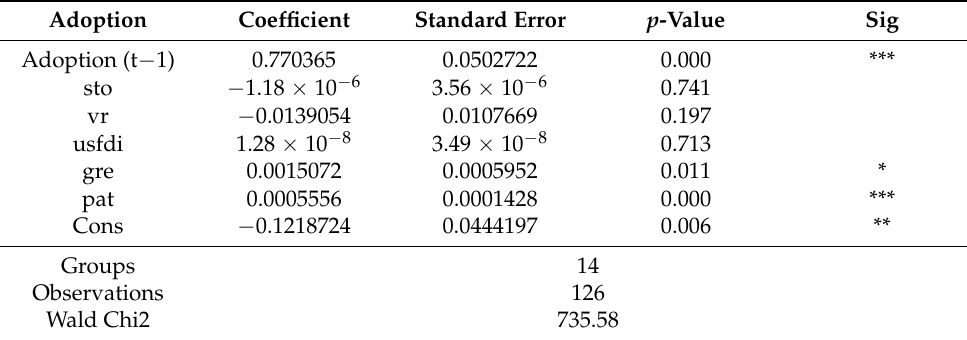
Table 2. Estimation results (Arellano–Bond